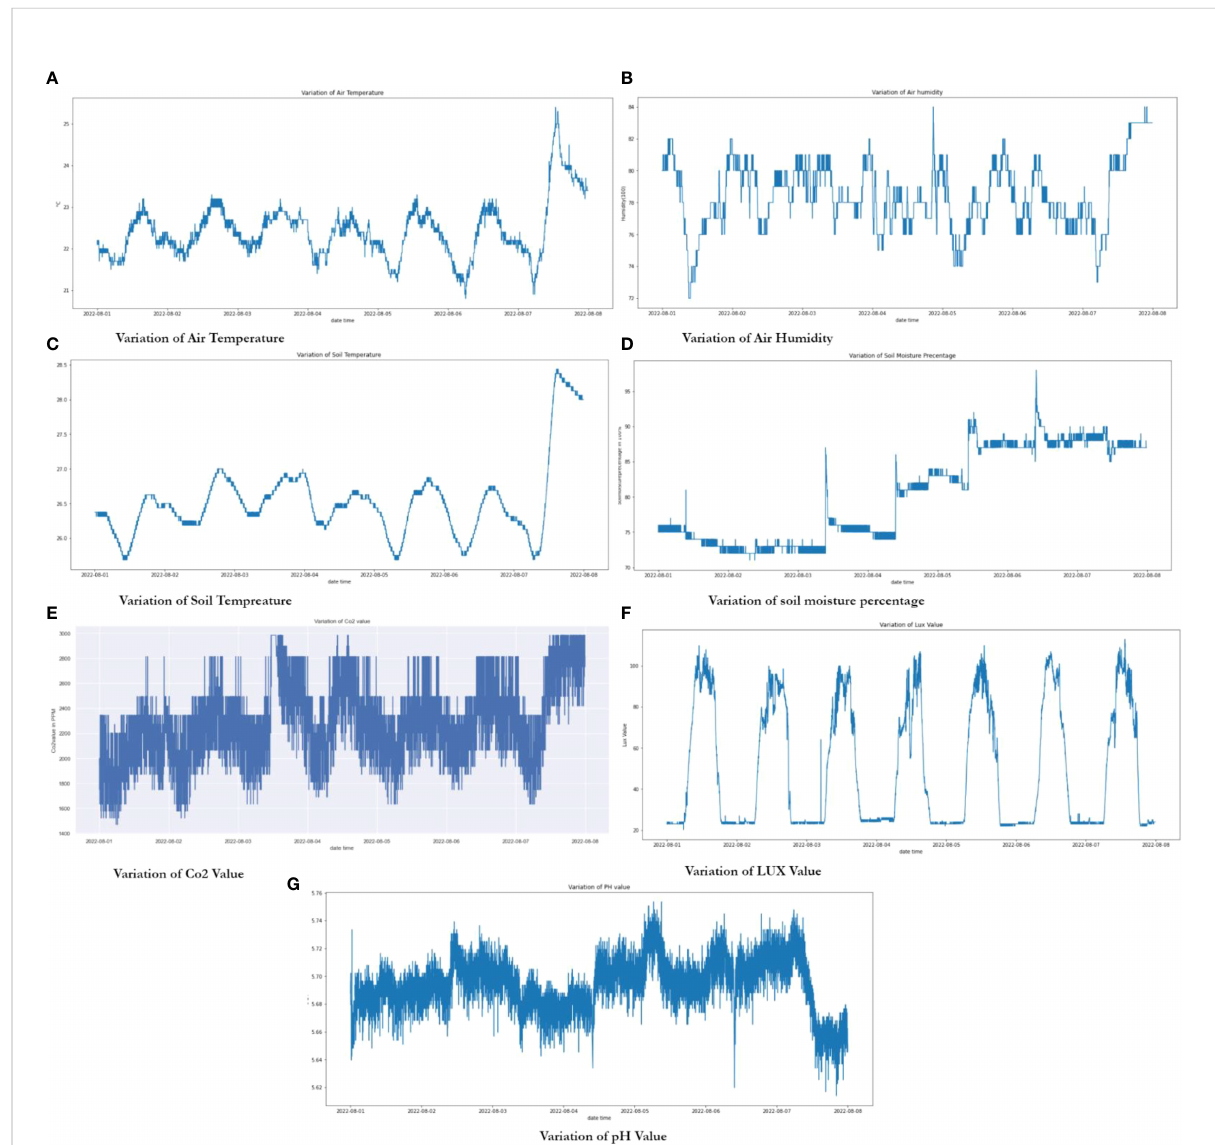
FIGURE 16 Variation of environmental and soil parameters; (A) Variation of Air Temperature, (B) Variation of Air Humidity, (C) Variation of Soil Temperature, (D) Variation of soil moisture percentage, (E) Variation of Co2 value , (F) Variation of LUX value , (G) Variation of pH